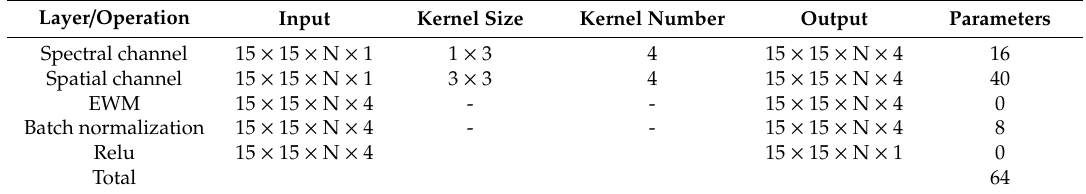
Table 1. Number of parameters in convolutional layers of each S2FEF block.